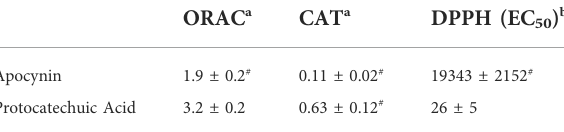
TABLE 1 Free radical scavenging activity of the studied